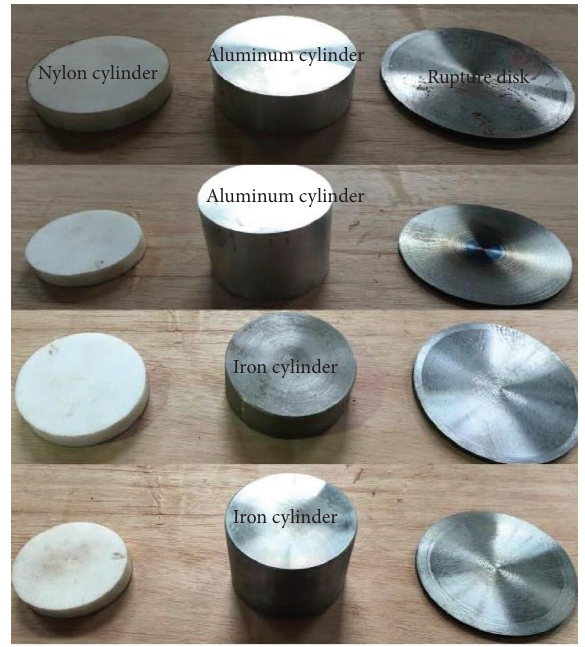
Figure 3: Iron and aluminum cylinders with diferent